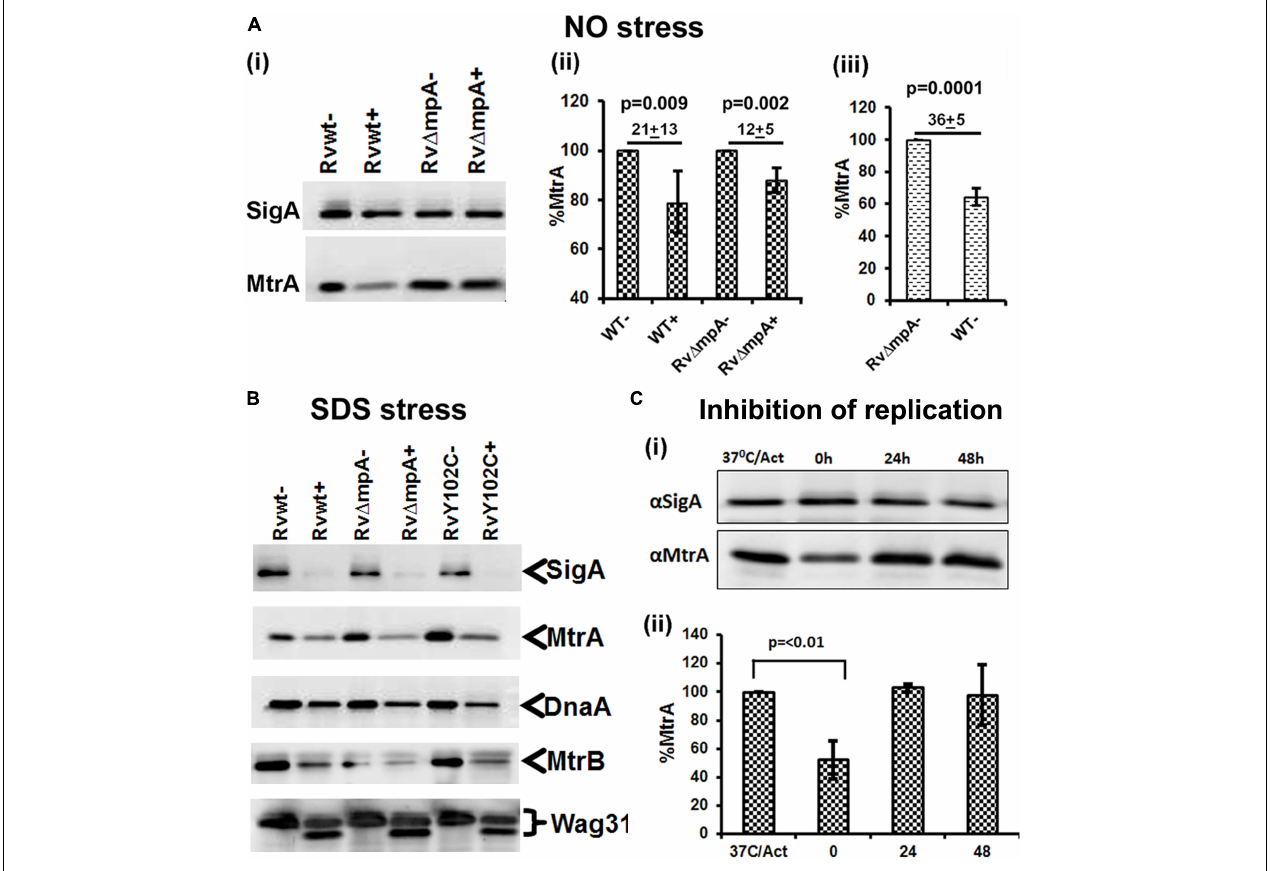
FIGURE 4 | MtrA levels decrease under stress and replication-arrest. Two micrograms of total protein lysates from WT and Rv (cid:49) mpa strains exposed to DETA-NO (A) , SDS (B) and isolated from temperature sensitive M. tuberculosis dnaA Ts mutant strain (Nair et al., 2009) (C) were resolved by SDS-PAGE, transferred to PVDF membranes and immunoblotted with α -MtrA, α -DnaA or α -SigA and quantitated as described (Fol et al., 2006; Rajagopalan et al., 2010). In all cases, untreated cultures are marked with ‘–‘ and treated with ‘+’. (A) Includes 3 sub-panels– (i) : immunoblots showing SigA and MtrA proteins. (ii) MtrA and SigA specific bands were quantified using the volumetric analysis tool of the QuantityOne software, the MtrA/SigA ratio was calculated and data presented as percent MtrA level in WT and Rv (cid:49) mpa mutant strains treated with DATA-NO, treating the MtrA level in WT and mutant strains not treated with DATA-NO as 100%. (iii) Percent of MtrA level in WT strain in comparison to MtrA level in Rv (cid:49) mpa strain, treated as 100%. (B) Immunoblots of SigA, MtrA, DnaA, MtrB, and Wag31 levels in M. tuberculosis strains. (C) Total protein lysates were isolated from dnaA Ts cells collected at four different time points of the synchronization plan: 37 ◦ C/Act – actively growing cells at 37 ◦ C; 0 – cells shifted to 30 ◦ C and grown for 30 h; 24 – cells shifted to 37 ◦ C and grown for 24 h; 48 – cells shifted to 37 ◦ C and grown for 48 h. The schematic of typical dnaA Ts synchronization plan is shown on Supplementary Figure S6 (i) immunoblots showing MtrA and SigA proteins. (ii) The MtrA/SigA ratio was calculated as described above. The bar graph shows the percent of MtrA protein level at indicated time period: 0, 24, 48 h in synchronized cells, treating the MtrA level in actively growing cells at 37 ◦ C (37 ◦ C/Act) as 100%. All data shown are averages ± standard error from three independent experiments. The statistical analyses were performed using the Student’s t